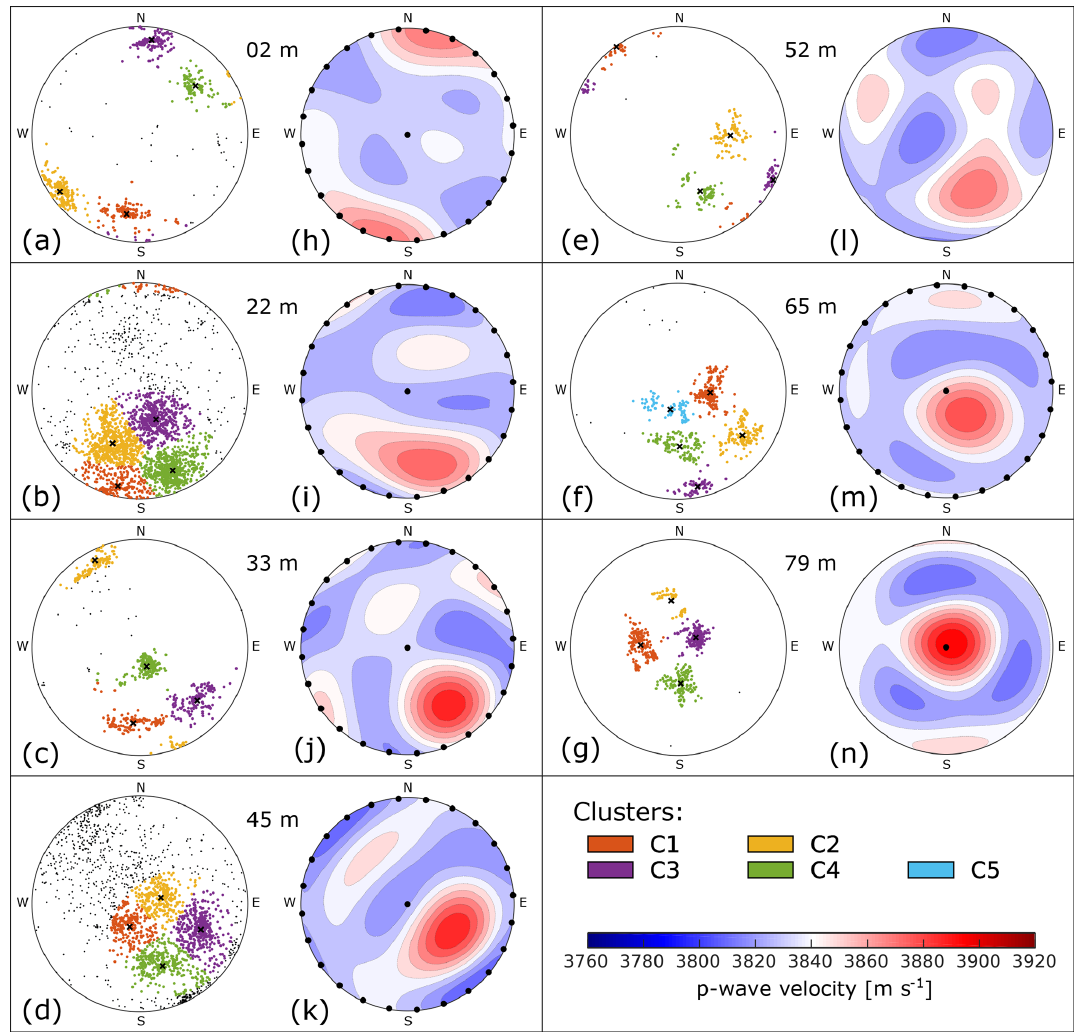
Figure 2. COF patterns and calculated seismic velocities for all seven analysed ice core samples: (a–g) c -axis distribution on a lower hemisphere Schmidt plot (the core’s vertical axis aligns with the centre of the plot). The grains associated with the individual clusters are colour-coded. (h–n) Seismic P wave velocities (derived from COF, no air correction) for any azimuthal direction and incident angle plotted on a lower hemisphere net. They were plotted with the Matlab toolbox MTEX (Mainprice et al., 2011). The black dots symbolise the sets of angles ( ϑ/ϕ ) for the ultrasonic